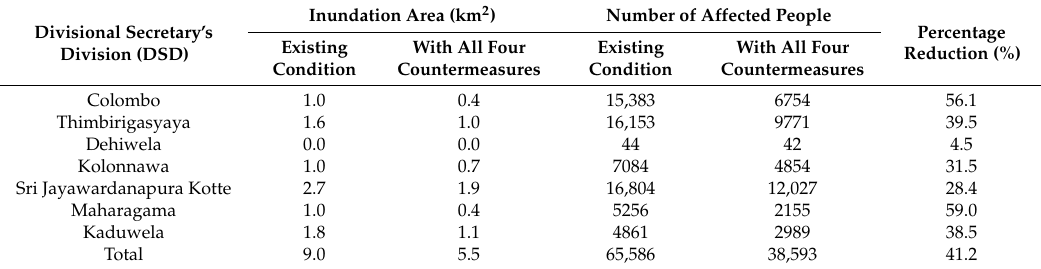
Table 9. Inundation area and affected people in DSDs for 2010 November rainfall.